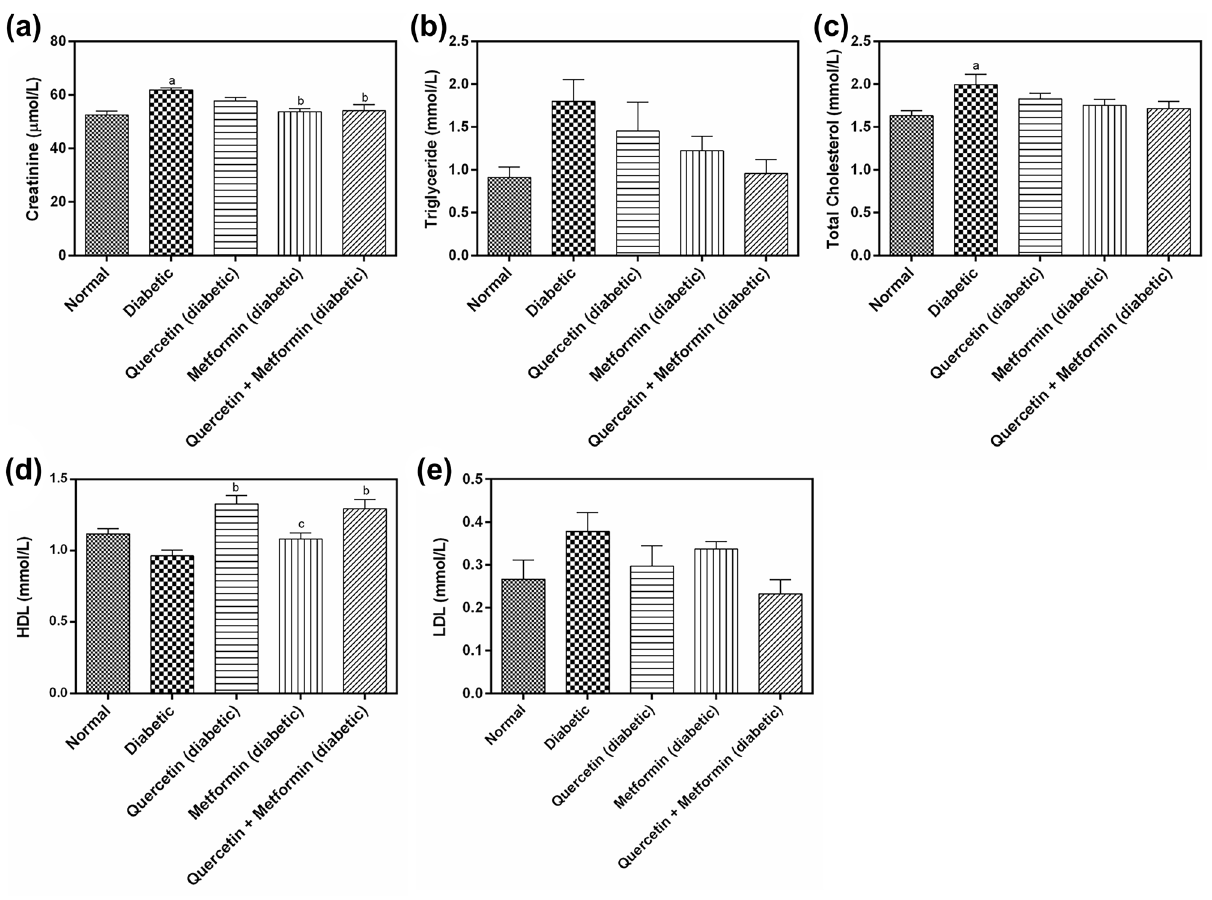
Figure 3. Effect of test compounds on plasma, ( a ) creatinine, ( b ) triglyceride (TG), ( c ) total cholesterol (TC), ( d ) high density lipoprotein (HDL), and ( e ) low density lipoprotein (LDL) in diabetic rats. Data represents mean ± SEM. The alphabet, ‘a’ shows a significant difference in comparison with normal control ( p < 0.05). The alphabet, ‘b’ shows a significant difference in comparison to diabetic control ( p < 0.05).